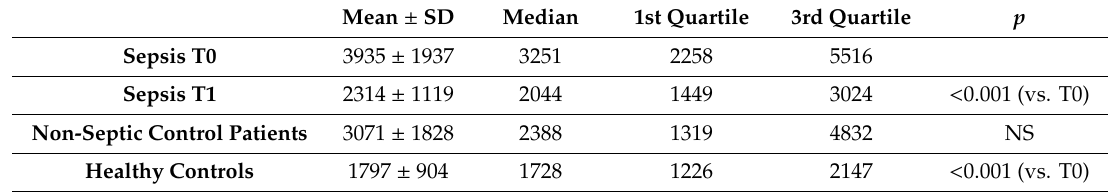
Table 3. Numbers of annexin V + microparticles in patients with sepsis, on admission (T0) and